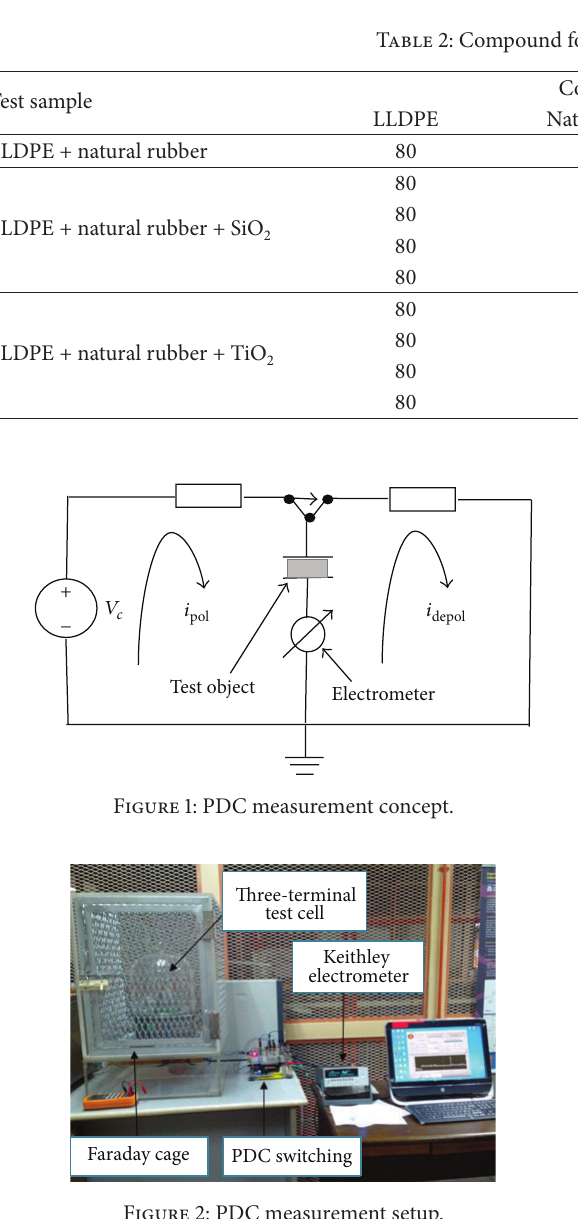
Figure 2: PDC measurement